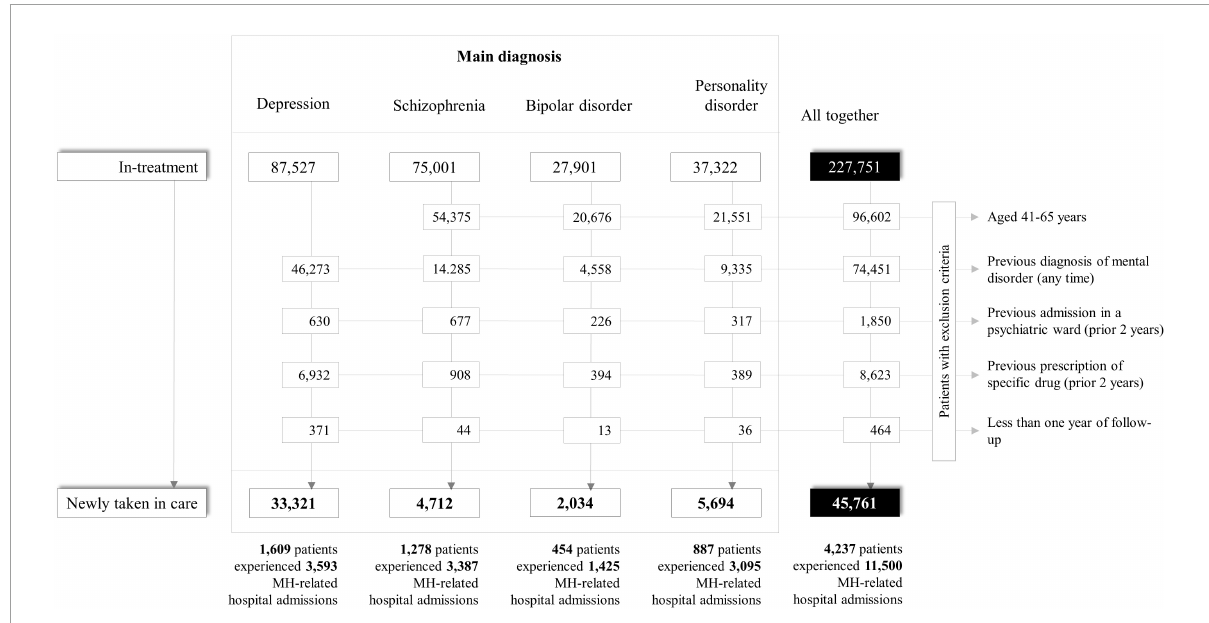
FIGURE1 Flow-chart of inclusion and exclusion criteria for patients with severe mental health disorders. QUADIM-MAP project, Italy,